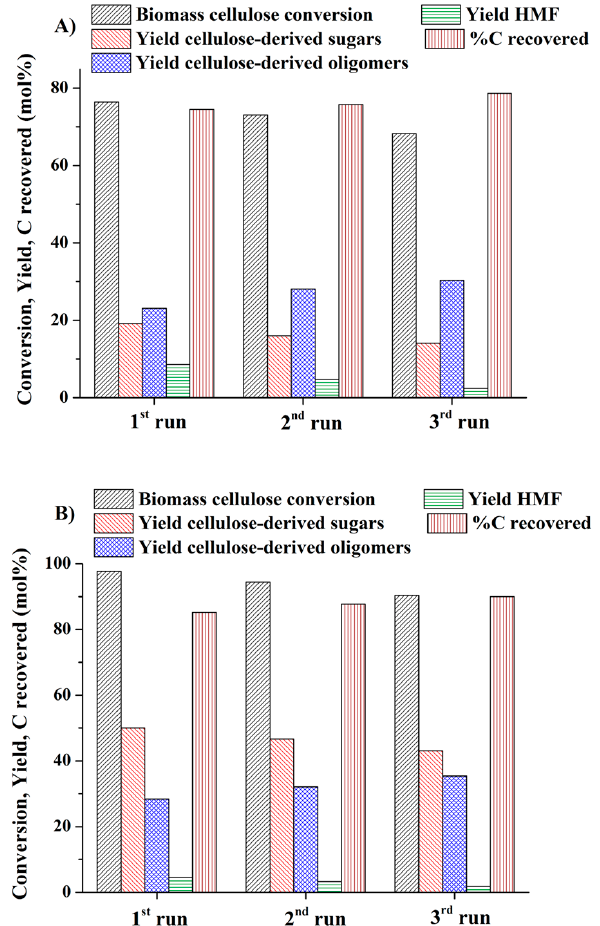
Figure 11. Conversion of Jerusalem artichoke cellulosic fraction in the recycle runs of: ( A ) NbPO and ( B ) ZrPO at 150 ◦ C. Reaction conditions: biomass = 2.68 g catalysts = 2.23 g water = 51.0 g T = 150 ◦ C, autogenic pressure, 1 h. As reported in the Materials and Methods, yields have been calculated with respect to the amount of cellulose or hemicellulose present in the starting biomass.